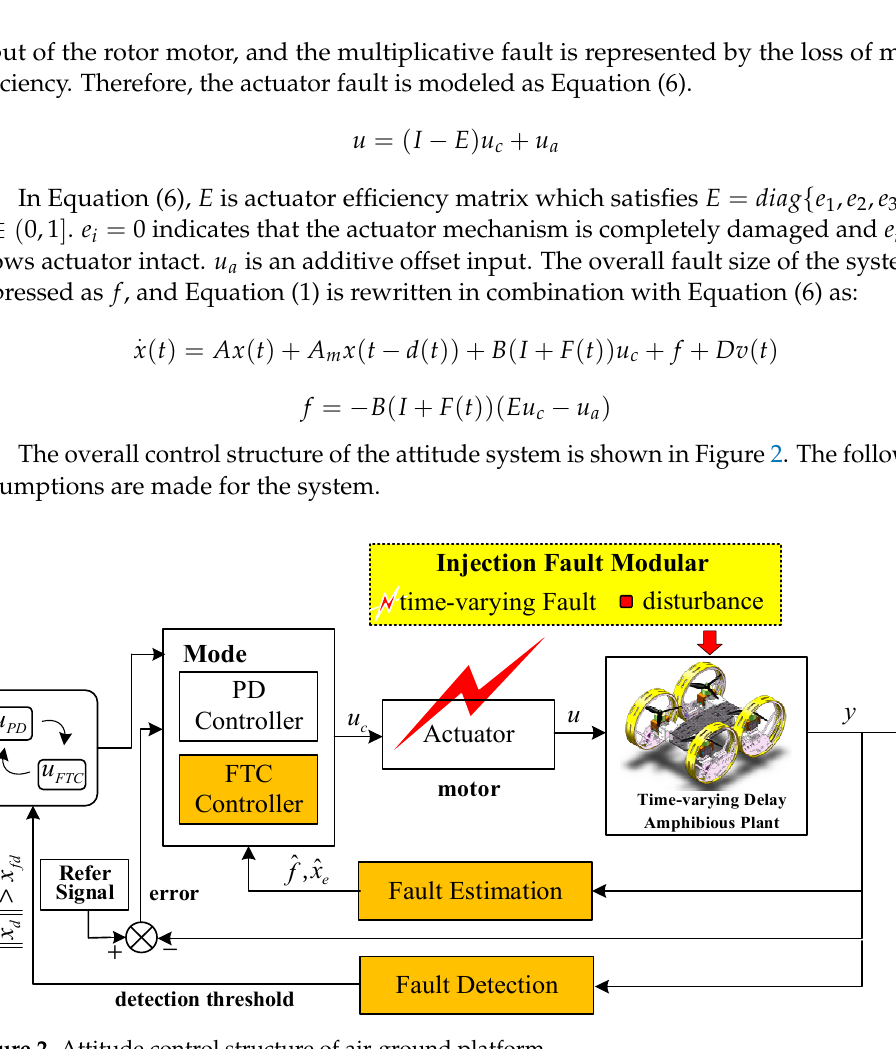
Figure 2. Attitude control structure of air-ground platform.